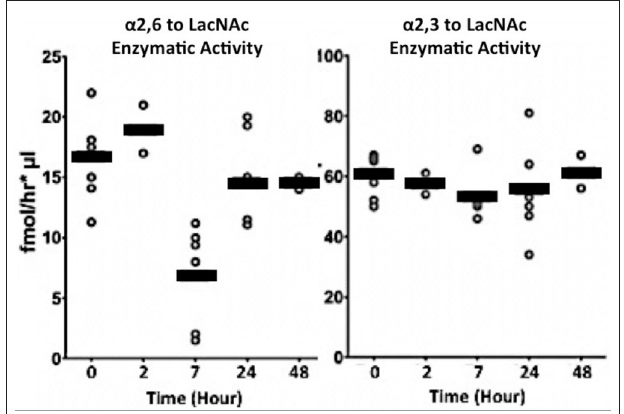
FIGURE 1 | Transient depression of circulatory ST6Gal-1 accompanies acute airway inflammation. Live NTHI bacteria (10 6 CFU / animal) were delivered by oropharengeal instillation. Blood was collected at the times shown after instillation. Sialyltransferase activities in the sera were measured by following the transfer of CMP-[3H]Sia to Gal β 1–4GlcNAc-O-Bn (LacNAc). The Sia α 2,6 product formed by ST6Gal-1 (Left) , was separated from Sia α 2,3 product formed by various ST3Gal transferases (Right) using SNA-agarose chromatography.